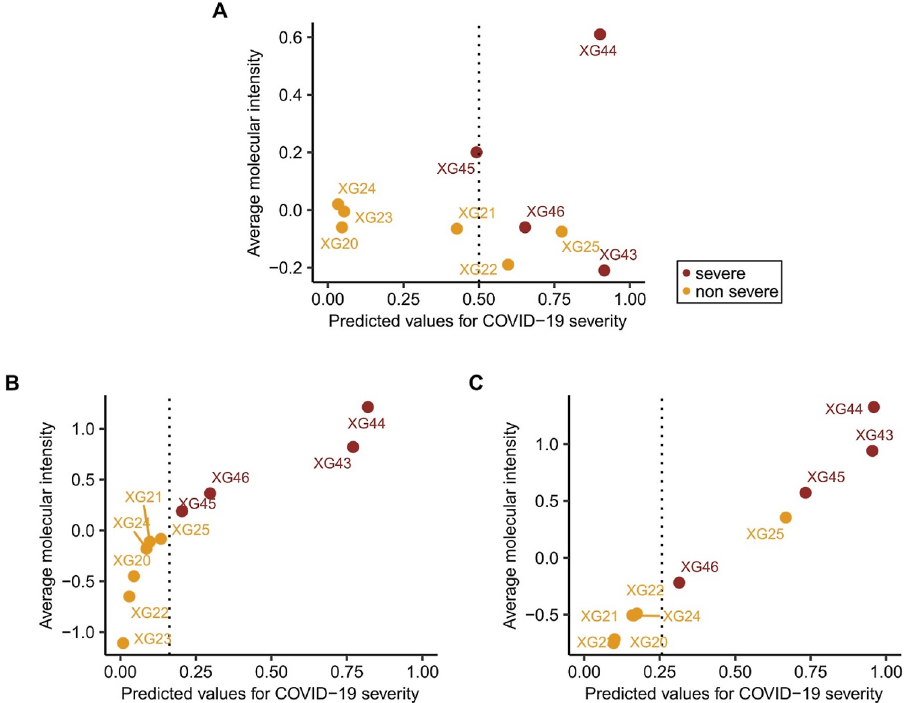
Figure 3. Validation performance results. ( A ) Shen et al.’s model (AUC = 0.875), ( B ) JADBio’s model—SAA2 and glycochenodeoxycholate 3-sulfate (AUC = 1), and ( C ) JADBio’s model—SAA2 and taurochenodeoxycholic acid (AUC = 0.958).